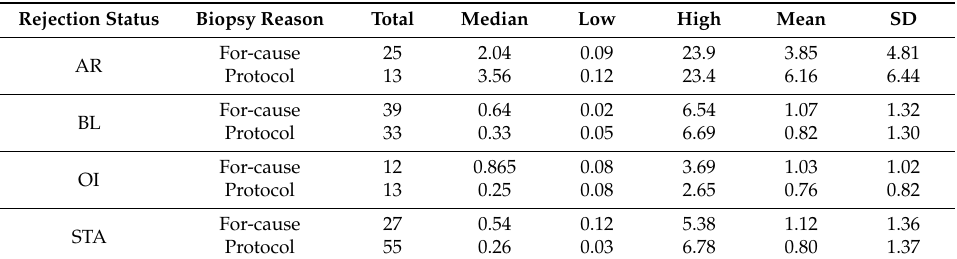
Table 3. Cohort breakdown into for-cause and protocol biopsy.